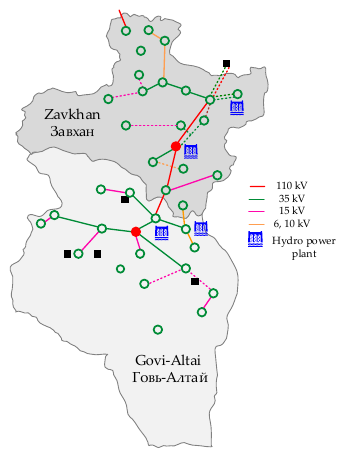
Figure 2. Representation of Altai-Uliastai regional power system (AURPS) indicating the main hydropower plants and transmission infrastructure.